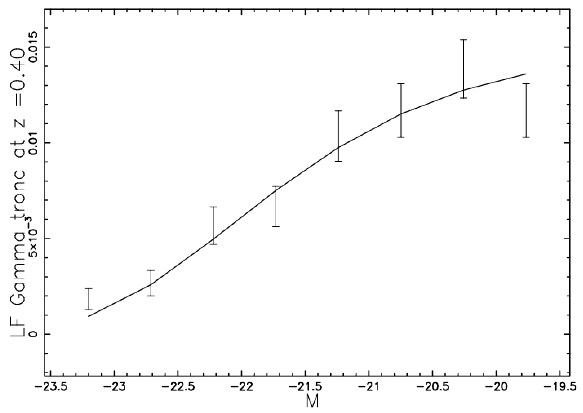
Figure 9. The luminosity function data of zCOSMOS are represented with error bars. The continuous line fit represents our gamma truncated LF (44); the chosen redshift is z parameters independent of the redshift are given in Table 3, and the upper magnitude-zrelationship is given in Table 4.